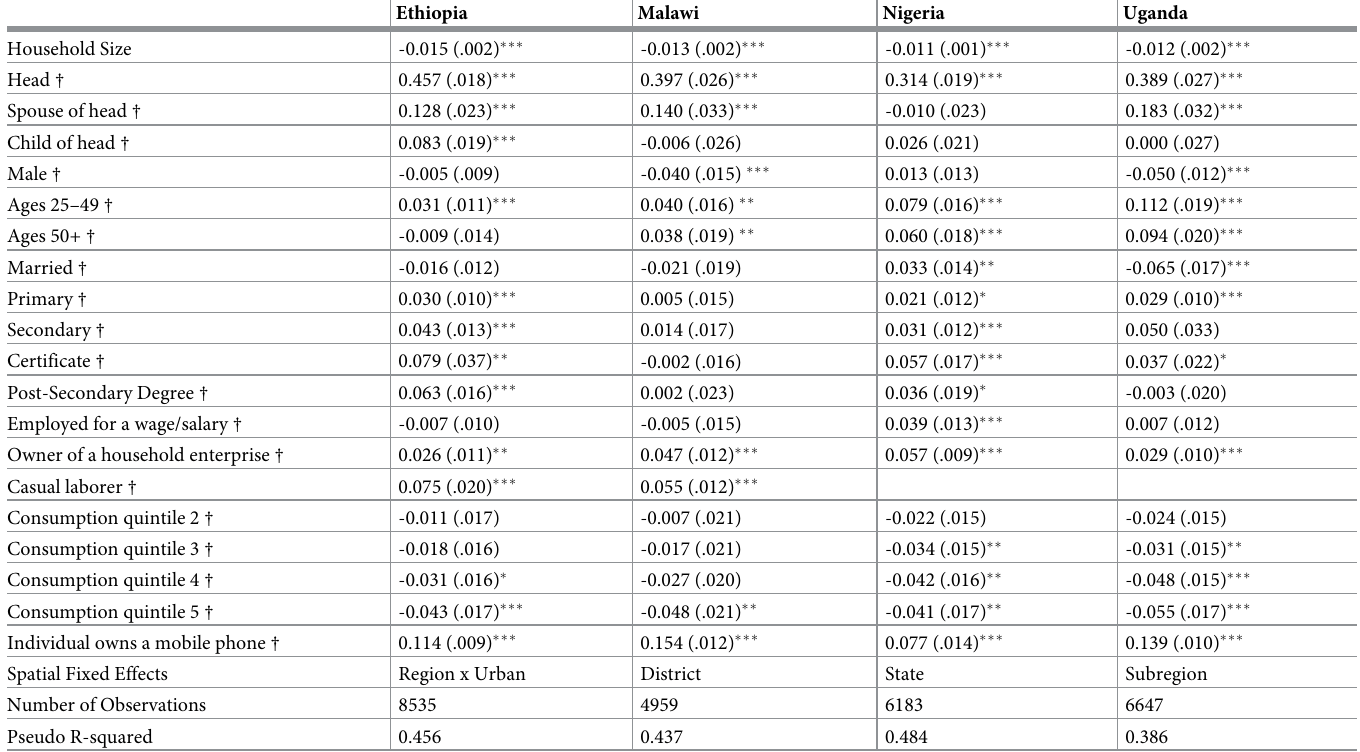
Table 3. Marginal effects from logit regressions on being a HFPS respondent in round